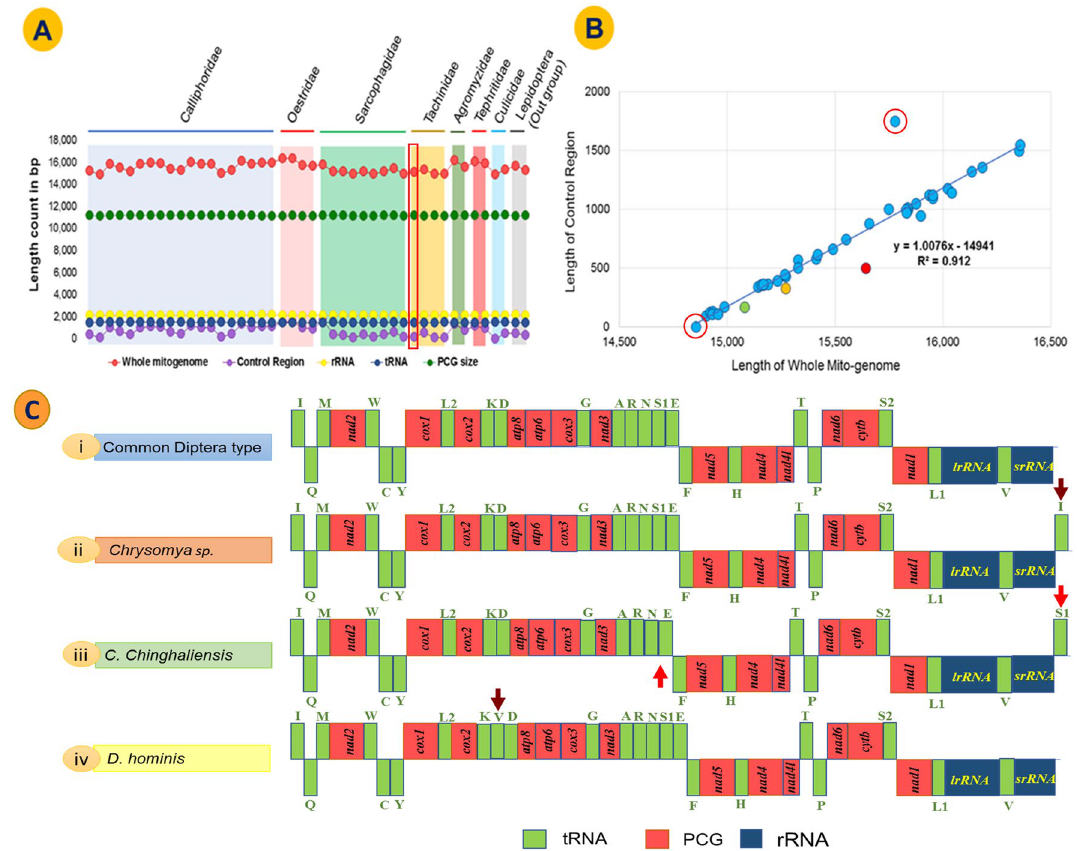
Figure 1. Size and arrangement of genes in the mitogenome; ( A ) Whole mitogenome (WMG), Protein- coding genes (PCG), tRNA, rRNA and Control region (CR) length variation among Oestroidea Superfamily, Red marked region Blepharipa sp. ( B ) Relation between WMG and CR length (R 2 = 0.912 p < 0.001). Green bubble = Blepharipa sp., Yellow bubble = Antheraea assamensis , Red bubble = Bombyx mori . The isolated bubbles marked in red circle represents Ravinia pernix and the Culex pipiens pipiens (see “Mitogenome annotation and documentation” section). ( C ) Gene arrangement of Blepharipa sp. mitogenome (i), a common ancestral Diptera type with respect to other selected exceptional arrangement of Oestroidea superfamily (ii, iii, iv). Downward brown arrow = Insertion of tRNA; Upward-downward red arrow = translocation of tRNA. The J strand genes were shown in upward direction and the N strand genes were downward